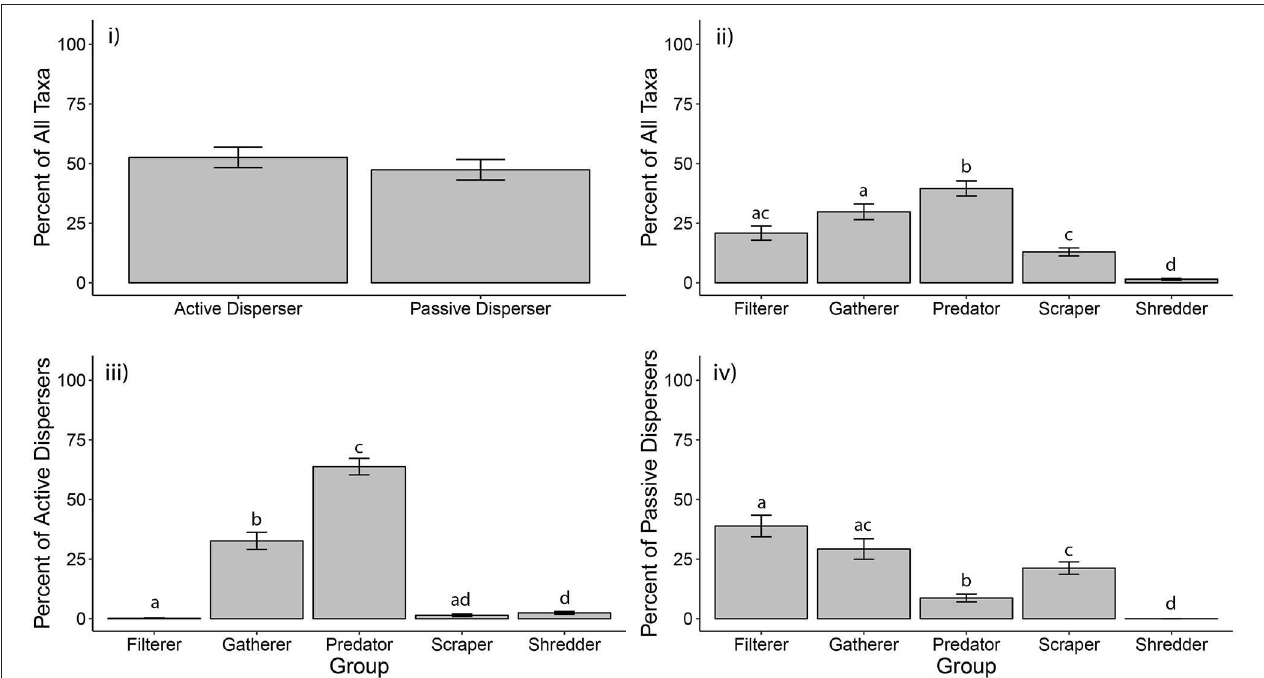
FIGURE 1 | Composition of macroinvertebrate dispersal and functional feeding traits in rock pools. Globally, the percentages of taxa classified as active vs. passive disperser were equal (i) , but more taxa were classified as predators and gatherers than any other functional feeding group (ii) . Within active dispersing taxa, most taxa were predators and gatherers (iii) , but the majority of passive dispersing were filterers, gatherers, and scrapers (iv) . Letters above bars indicate groups by significance, such that two bars with the same letter are not statistically different. Letters can only be compared within a graph, not across graphs.